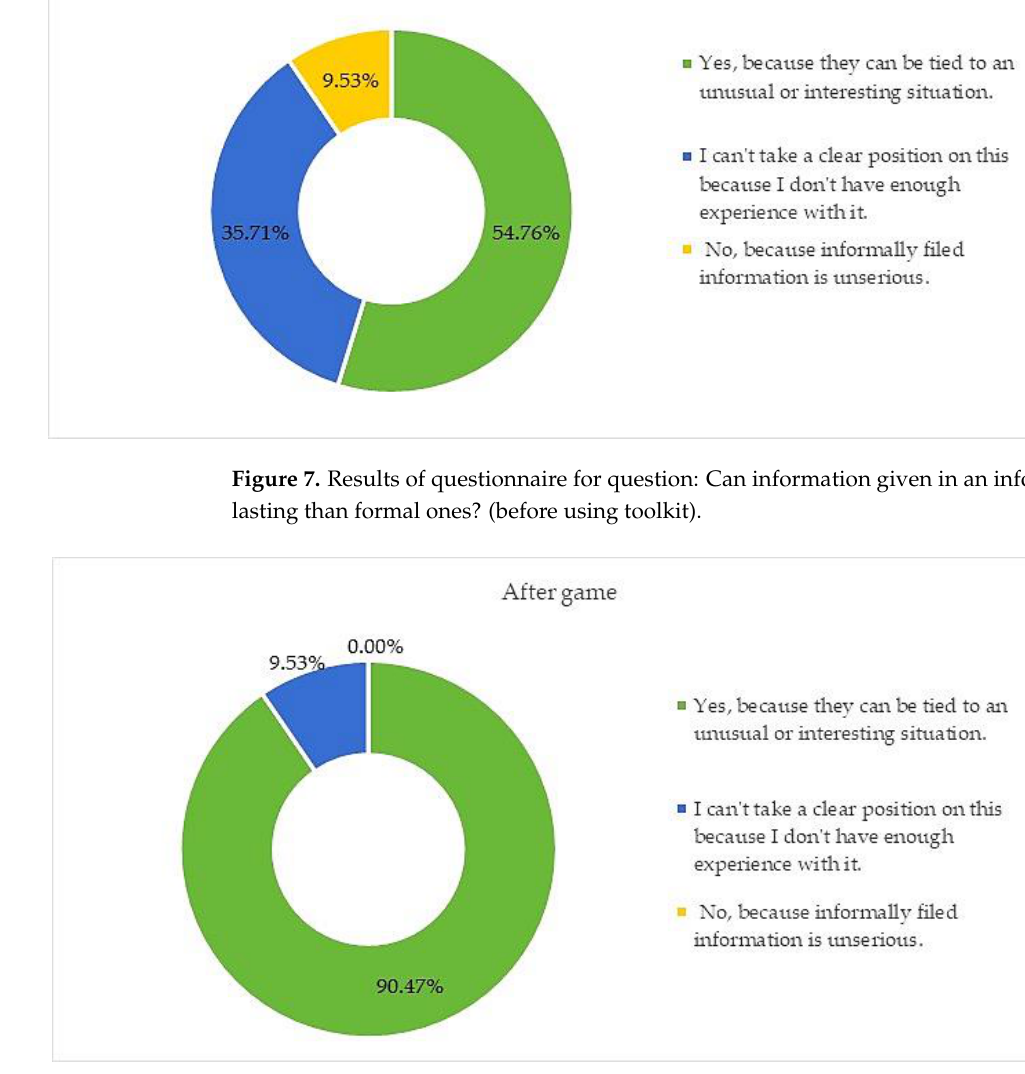
Figure 8. Results of questionnaire for question: Can information given in an informal way be more lasting than formal ones? (after using toolkit).